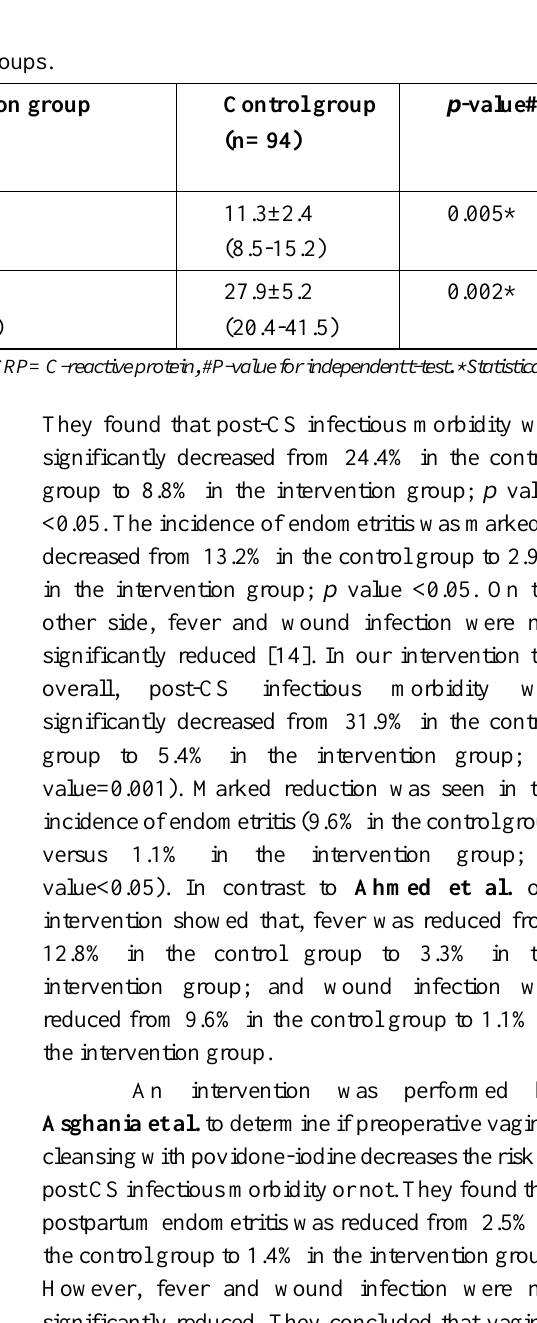
Table 2. Frequency of post-CS infectious morbidities among the studied groups. Infectious morbidities Endometritis 1(1.1%) 9 (9.6%) 0.01^^* 0.1(0.013-0.84) Fever 3(3.3%) 12(12.8%) 0.2 (0.06-0.85) Wound infection 1 (1.1%) 9(9.6%)